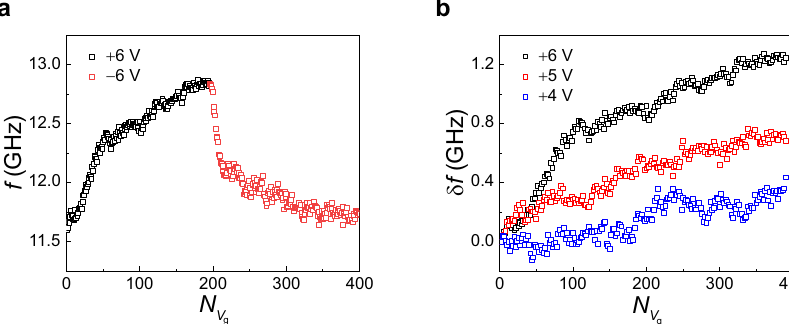
Fig. 5 Cumulative frequency control via repetitive gate voltage pulses. a The auto-oscillation frequency of the SHNO versus the number of positive (black) and negative (red) gate voltage pulses ( N V ). b Voltage-driven cumulative frequency change ( δ f ) versus N V g